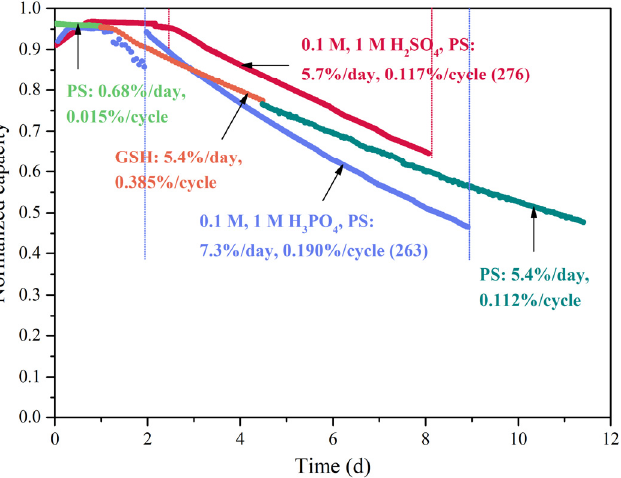
Figure A2. Capacity decay rate of O-1 in different supporting electrolytes (H 3 PO 4 or H 2 SO 4 ), using PS and GSH (galvanostatic with potential hold) cycling methods. Table A1. Condition, charge/discharge current and cell resistance of the symmetric cell cycling tests using the GS cycling method.